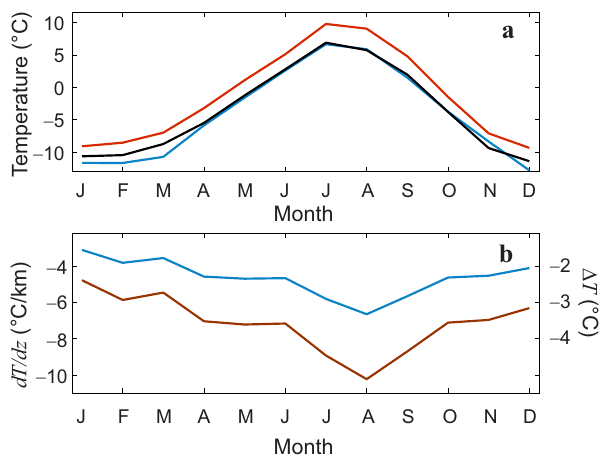
Figure 3. Mean monthly temperatures at Haig Glacier, 2002–2012. (a) GAWS (blue), FFAWS (red), and derived glacier means (black). (b) Temperature differences, GAWS–FFAWS (blue, scale at right, ◦ C) and as a “lapse rate” (brown, scale at left, ◦ Ckm − 1 ) .